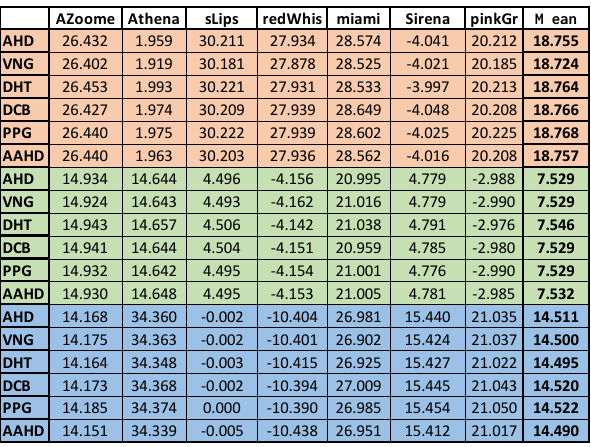
Figure 8: Average Differences in radiometric values for Red, Green and Blue of the 6 De-mosaicking algorithms for every dataset.